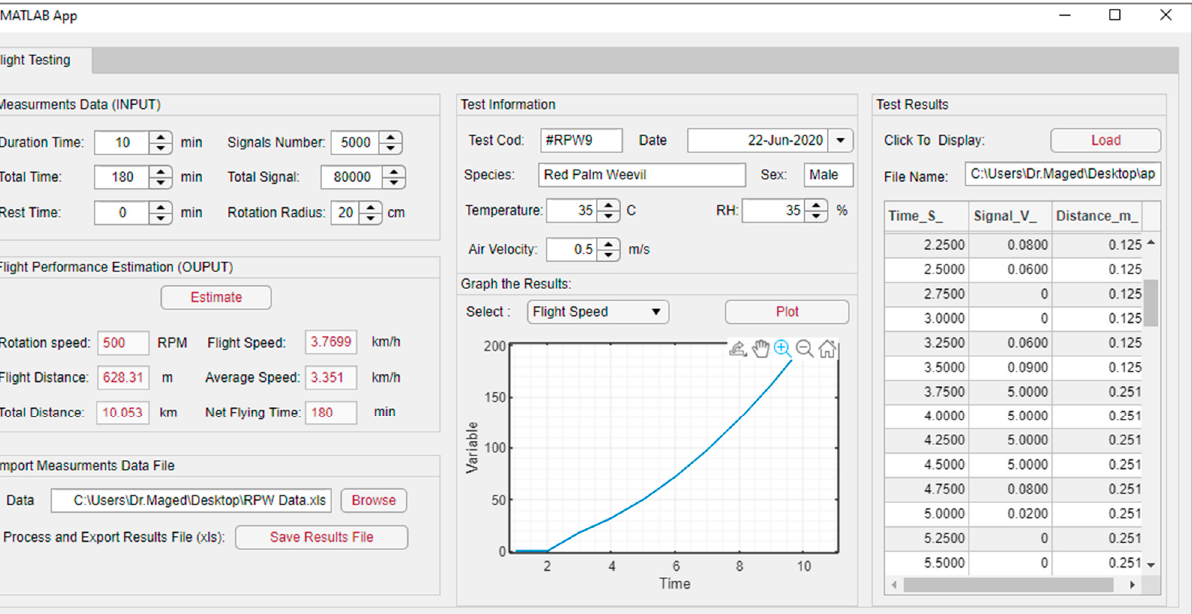
Figure 17. The main window of the graphical user interface (GUI) for estimation of R. ferrugineus flight parameters.